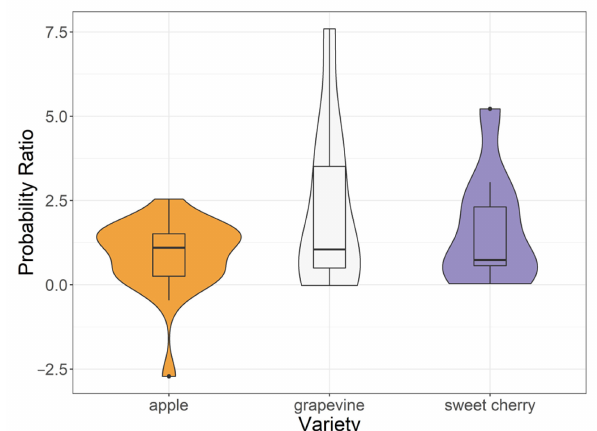
Figure 8. Violin plot of the modeled probability of spring frost ratio between P tf (2001–2020) and P tf (1981–2000) for the analyzed grapevine, apple, and sweet cherry varieties, in logarithmic scale. Additionally presented is the boxplot of the ratio